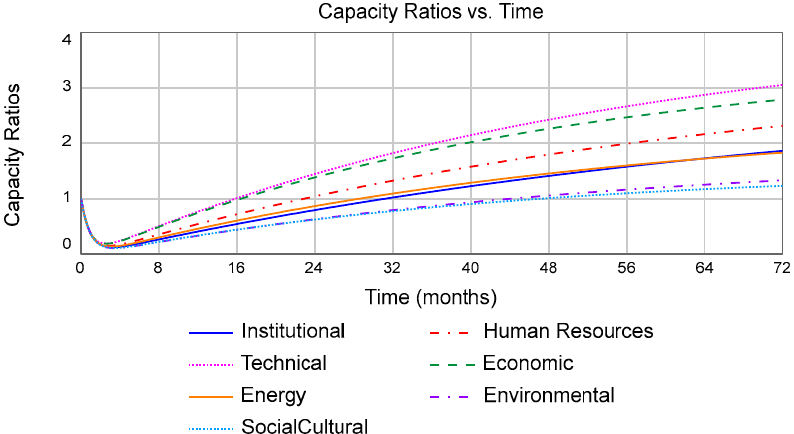
Figure 15. Variation of the ratio between current and initial capacity for all seven types of capacity over 72 months (six years).